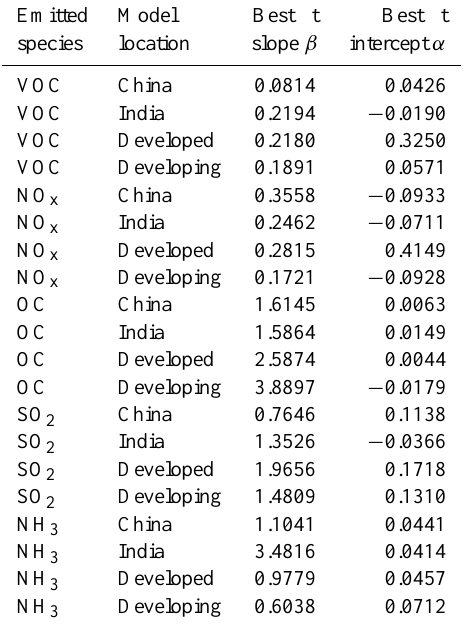
Table 4. Best fit emissions correlation statistics, based on Eq. (7). VOC and NO x emissions are linearly related to CO emissions while OC, SO 2 , and NH 3 emissions are linearly related to BC